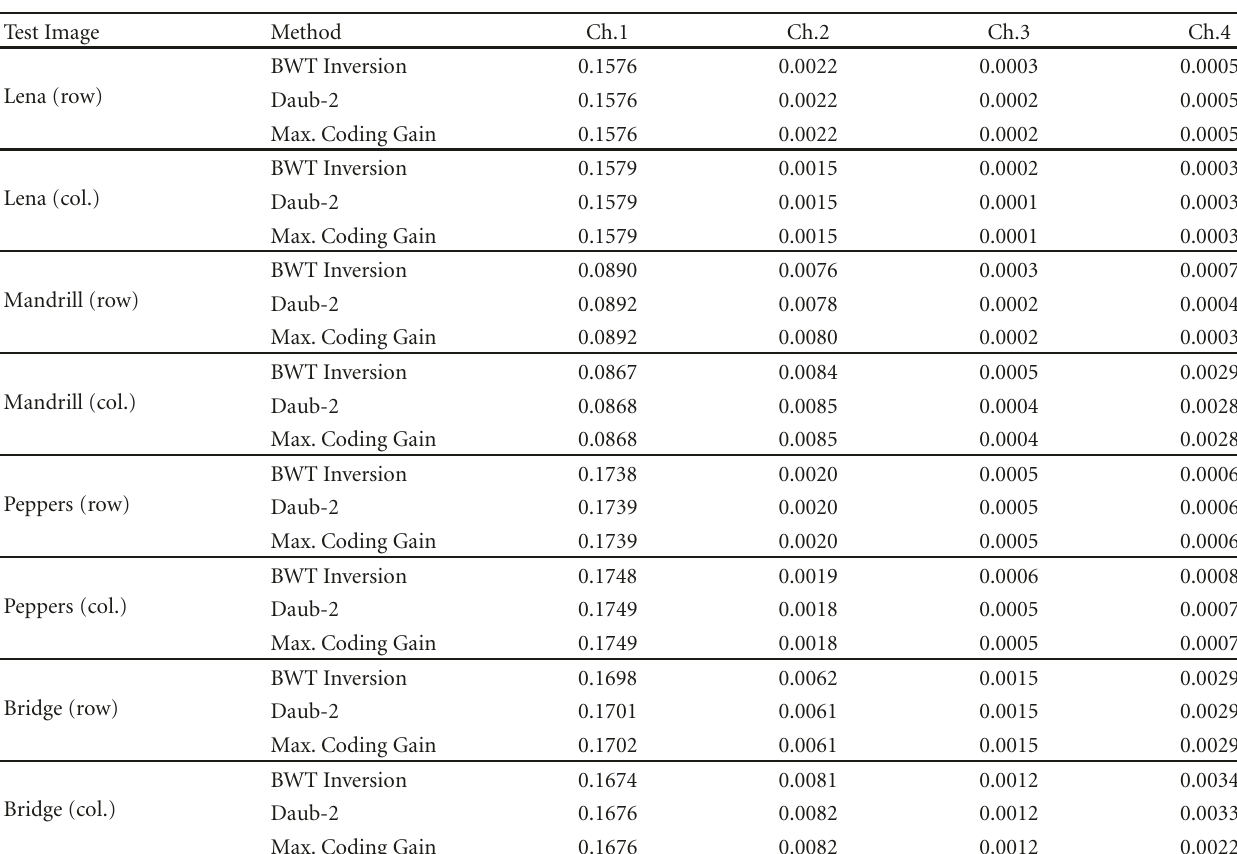
Table 6: Channel variances.